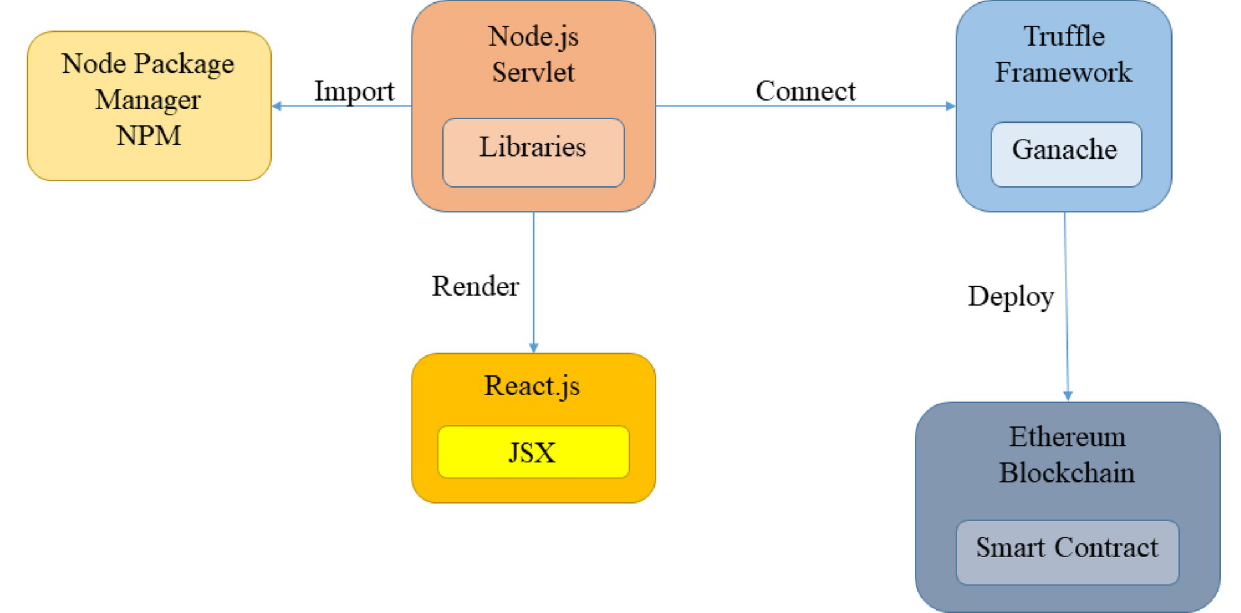
Fig 4. High-level overview of the development